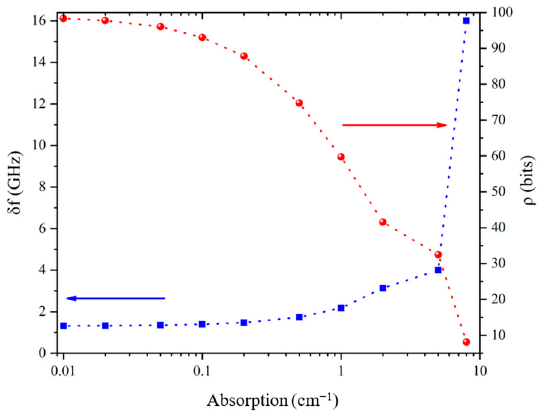
Figure 5. Variation of the channel width δ f (in blue) and of the corresponding coding capacity ρ (in red) versus the absorption coefficient of the materials used to fabricate the 19 layers’ tag.